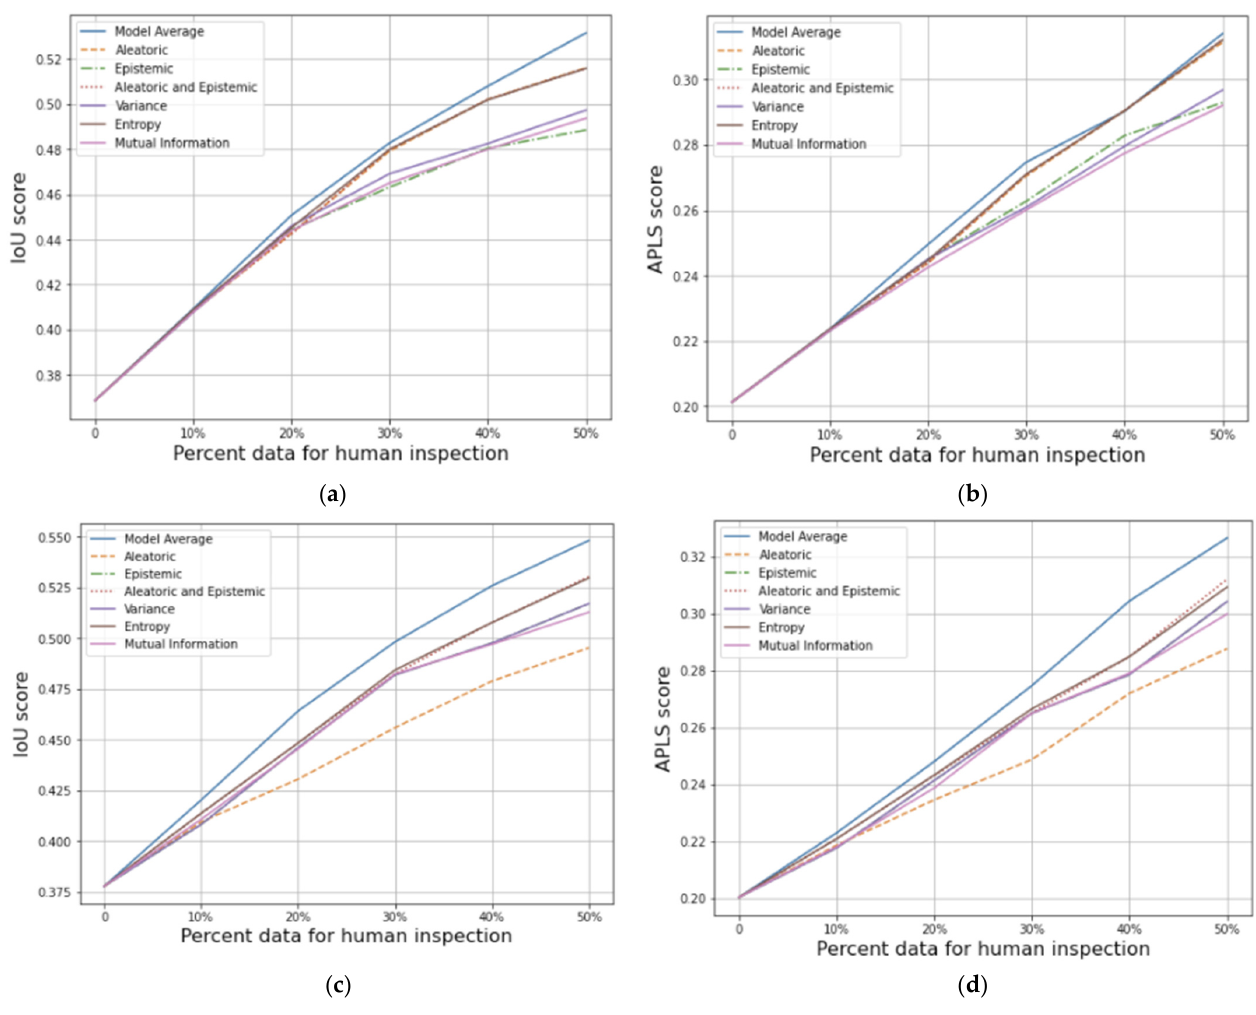
Figure 9. Performance comparison of aleatoric, epistemic, variance, entropy and mutual information uncertainty measurements against model averages for MCD ( a , b ) and DE ( c , d ) with ID data. Model averages perform better at all levels of thresholding. In the MCD case, the magnitude of epistemic uncertainty is small enough that it adds almost nothing to the aleatoric measurement when combined. Interestingly, epistemic measurements are more useful than aleatoric in the DE model, and vice-versa for the MCD model. This evidences the idea that DEs provide more diverse support to the predictive distribution than samples from MCD models.